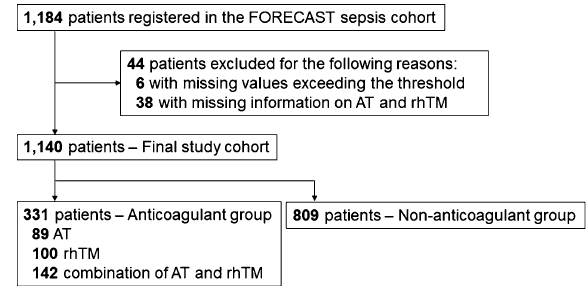
Figure 1. Flow chart of the study population. AT, antithrombin; FORECAST, Focused Outcomes Research in Emergency Care in Acute Respiratory Distress Syndrome, Sepsis and Trauma; rhTM, recombinant human